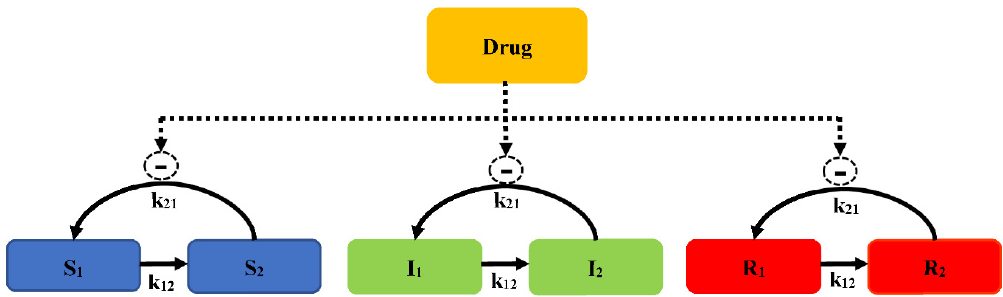
Figure 7. Schematic illustration of pre-existing resistance (Model 6).